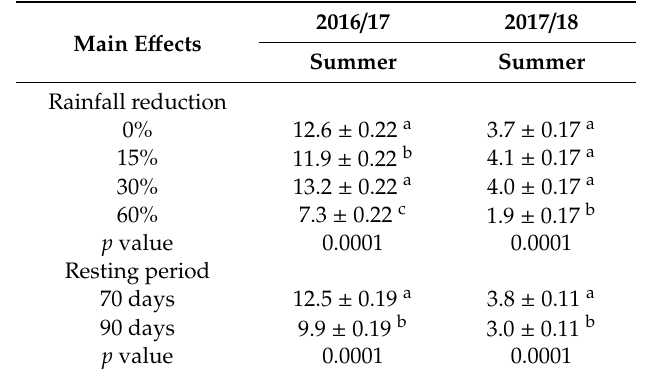
Table 8. Main e ff ect of resting period and rainfall reduction on rainwater use e ffi ciency (mean ± S.E) (kg.ha − 1 .mm − 1